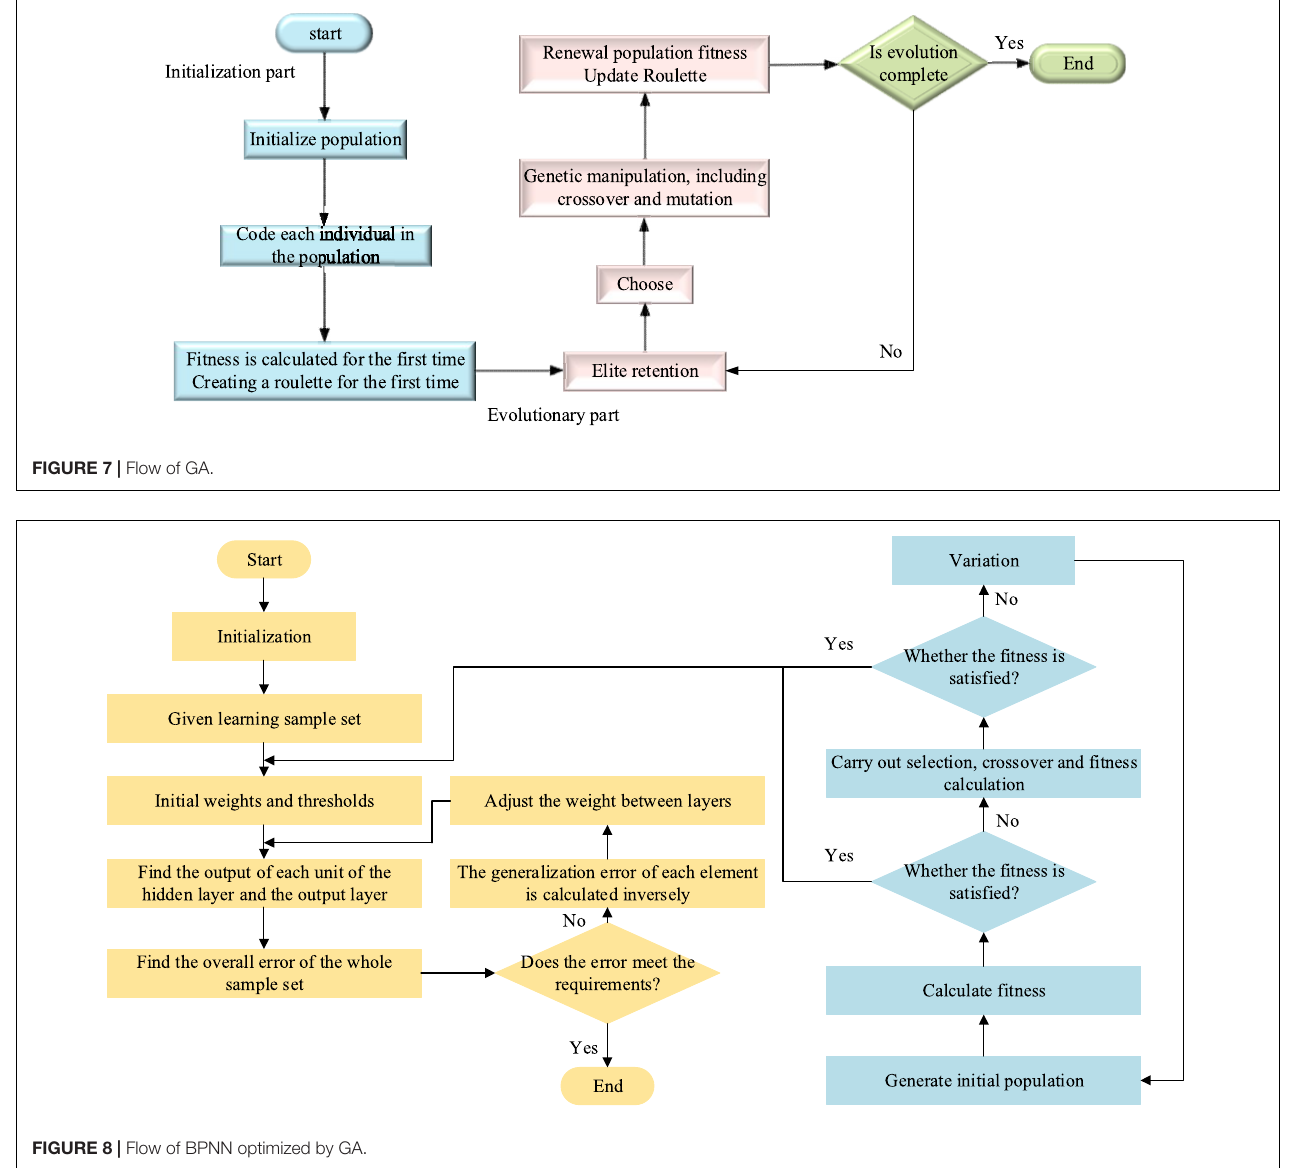
FIGURE 8 | Flow of BPNN optimized by